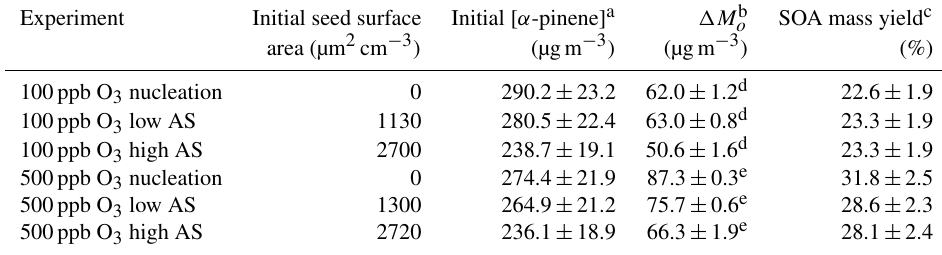
Table 1. Experimental conditions and results for the α -pinene ozonolysis experiments.